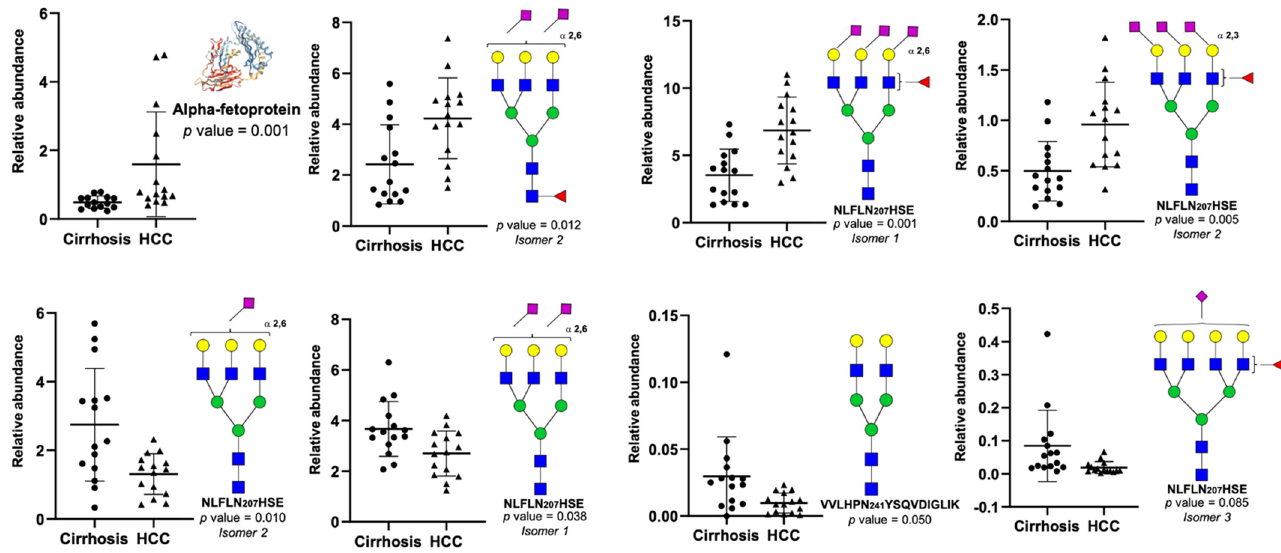
Figure 7. Alpha-fetoprotein and glycopeptide structures with significant difference between cirrhosis and HCC samples. NLFLN207HSE (Asn207), and VVLHPN241YSQVDIGLIK (Asn241).